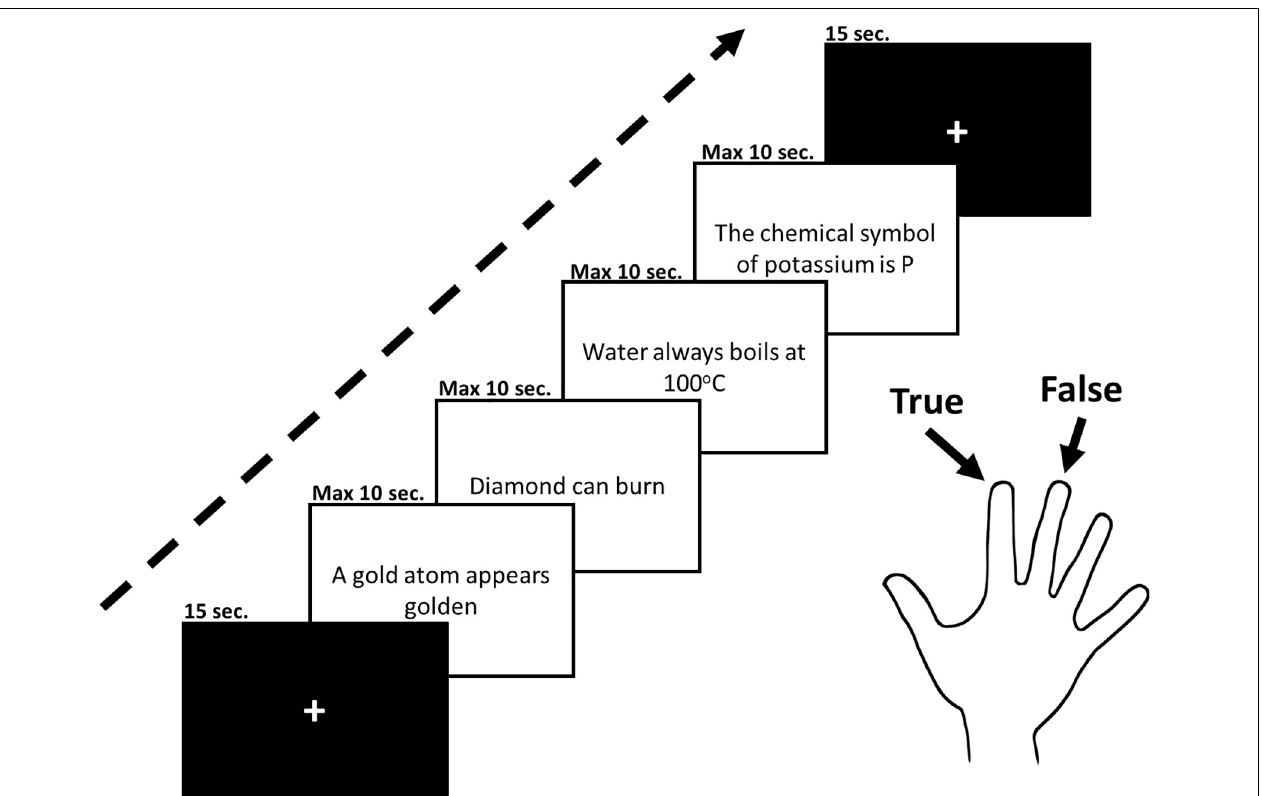
FIGURE 3 | Example of an incongruent block.